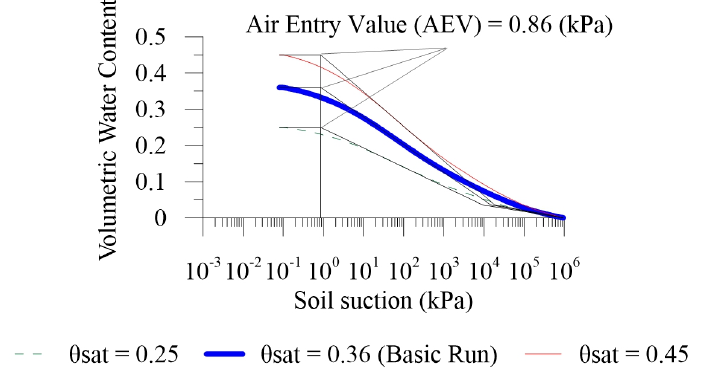
Figure 6. SWCC used for different θ sat